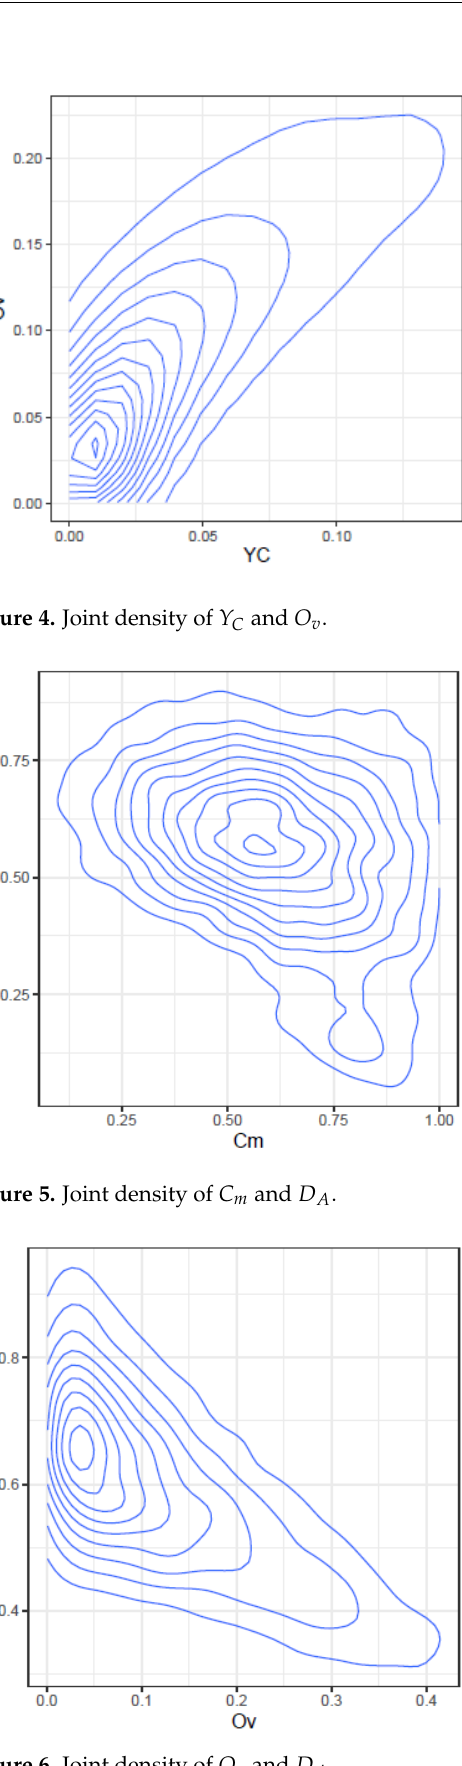
Figure 6. Joint density of O v and D A